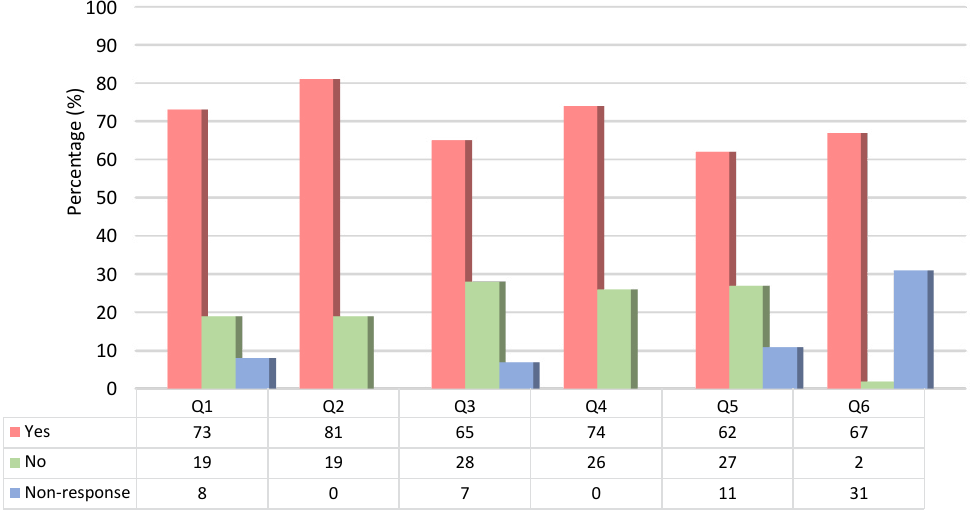
Fig. 13: Frequency percentages for the number of respondents to questions based on answers; part 1 of questionnaire